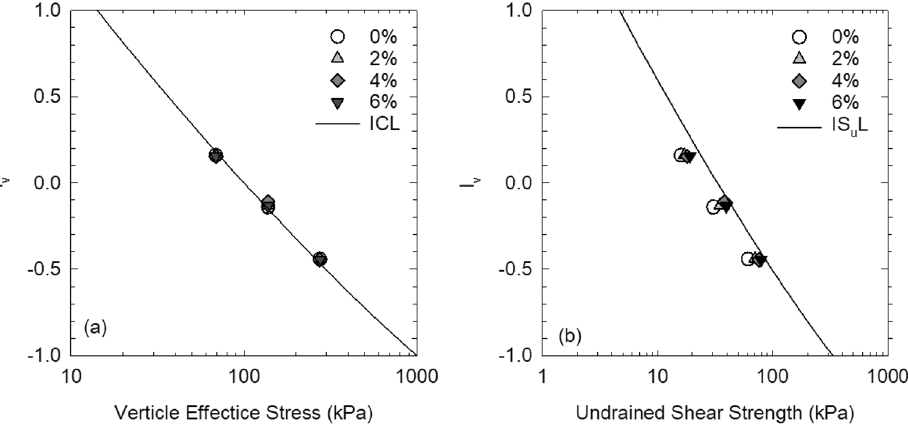
Figure 11. Void index versus ( a ) vertical effective pressure, and ( b ) undrained shear strength of soft marine clay with different porewater salinity.